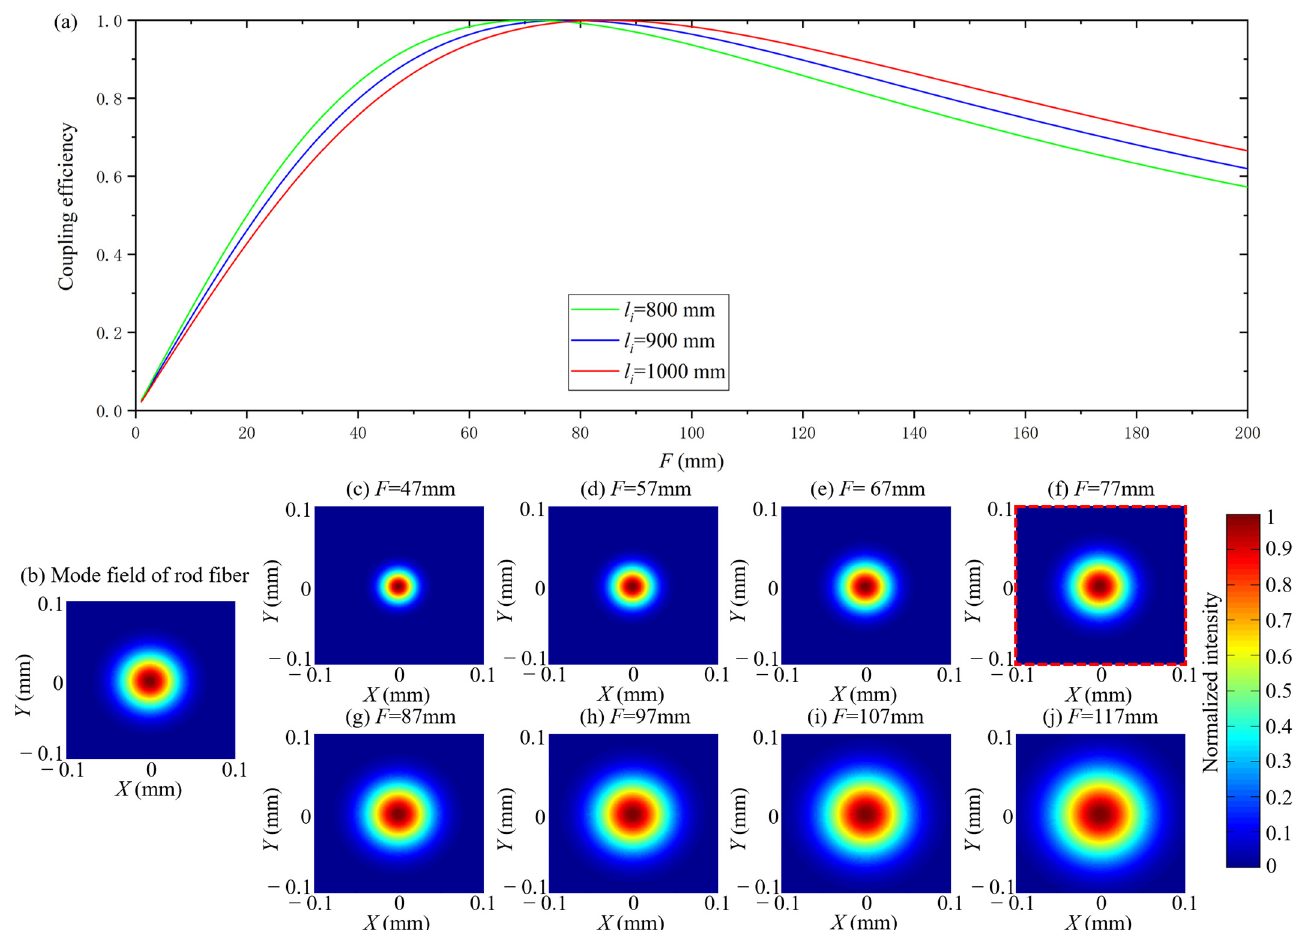
l l l = when o ( a ), the mode